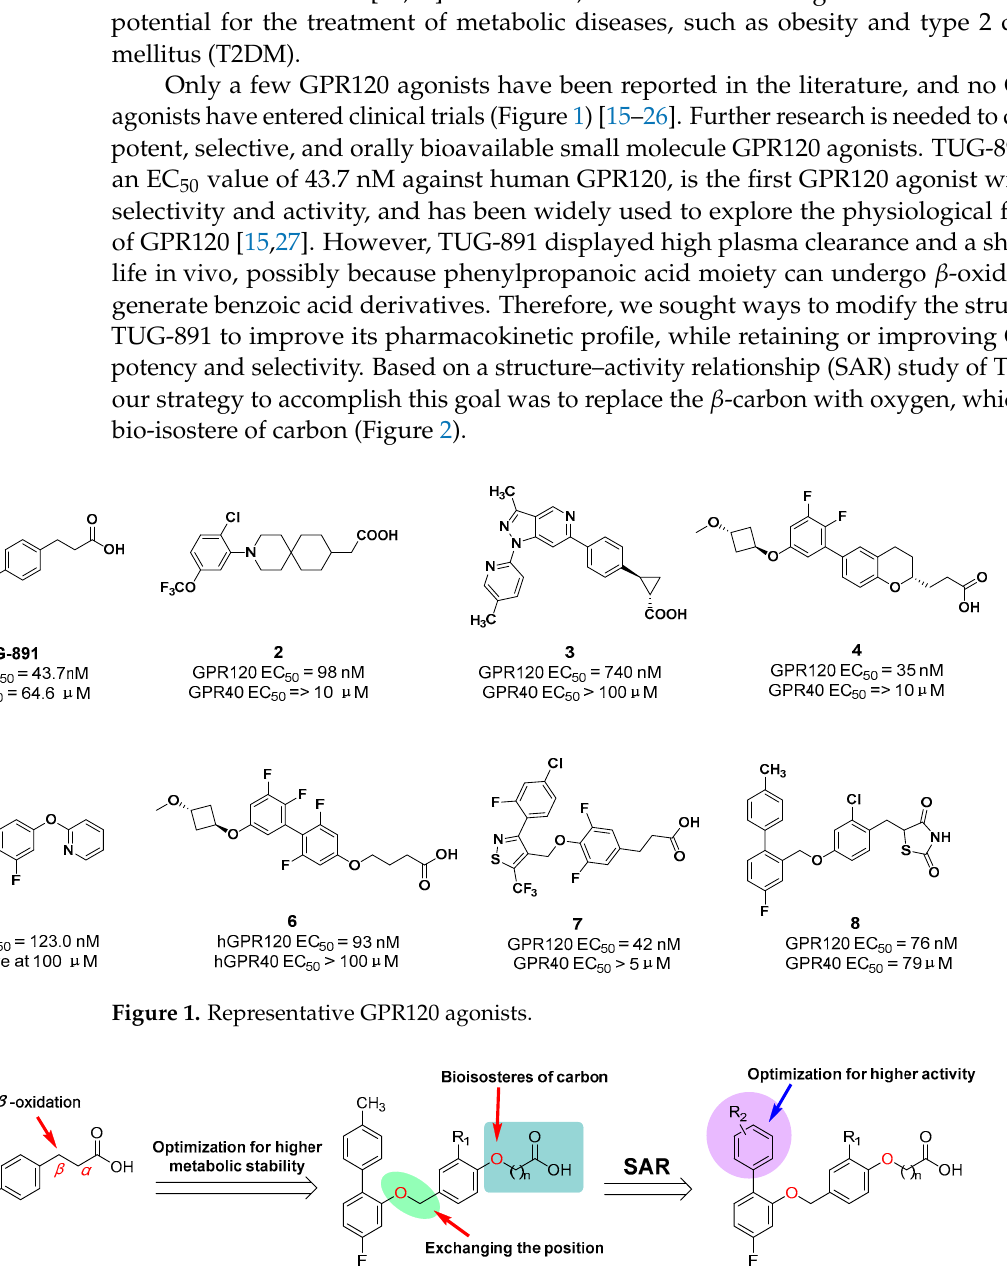
Figure 2. The design of phenoxyalkanoic acid derivatives.